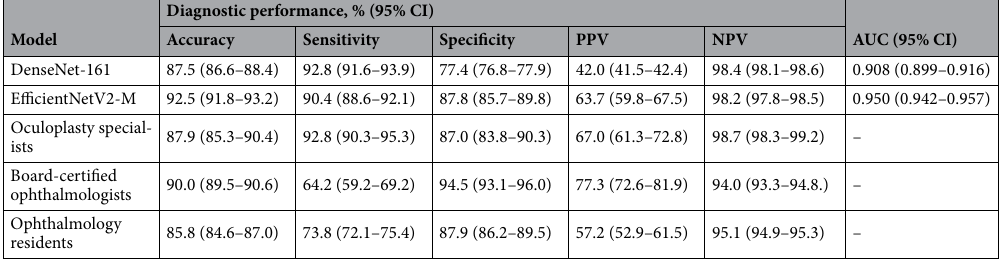
Table 3. Diagnostic performances of deep-learning models and human clinicians in differentiating malignant and benign eyelid lesions. AUC area under the receiver operating characteristic curve, CI confidence interval, NPV negative predictive value, PPV positive predictive value.